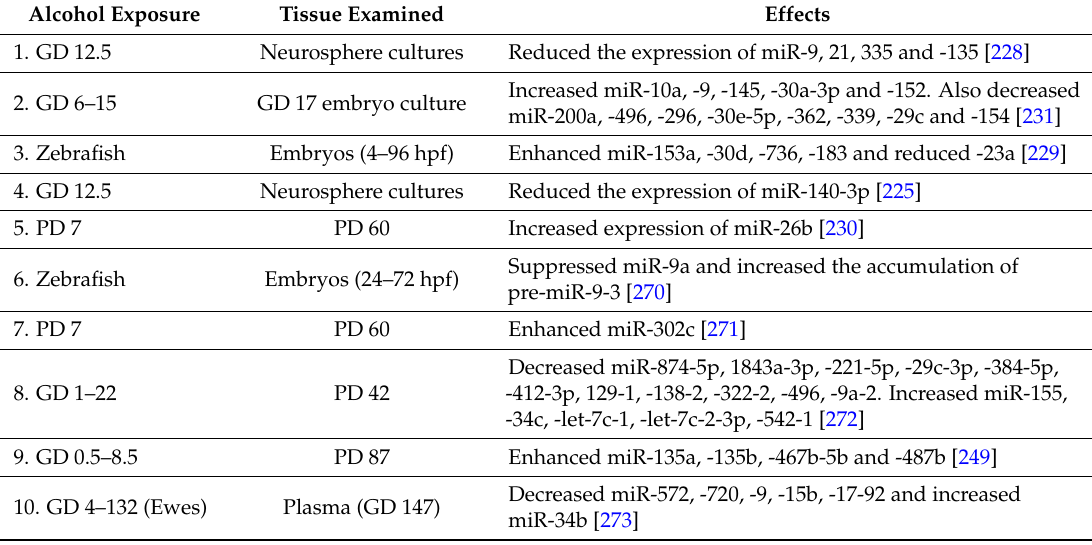
Table 3. Summary of the developmental alcohol elicited changes in